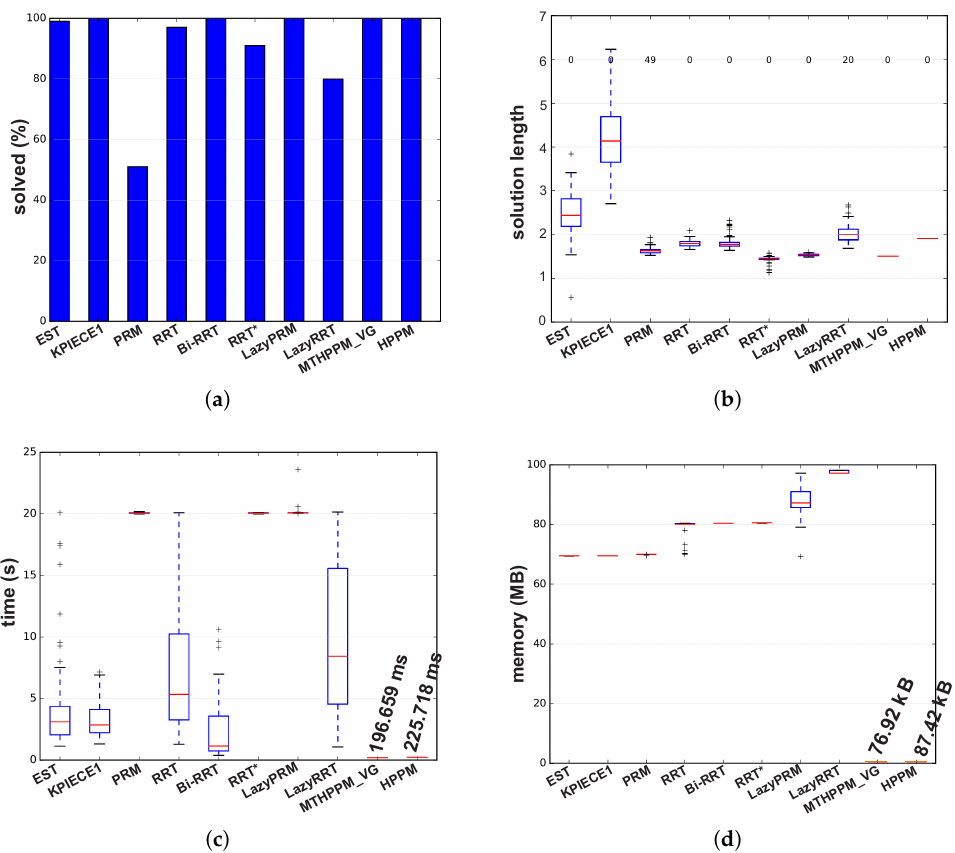
Figure 18. Comparative results for case study 1. ( a ) Successful paths. ( b ) Path length. ( c ) Execution time. ( d )